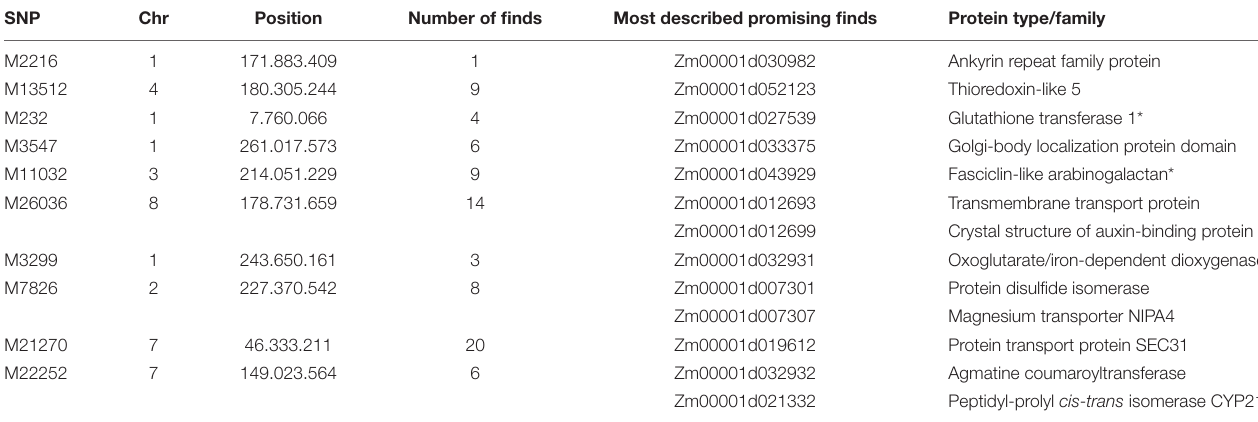
SNP Chr Position Number of finds Most described promising